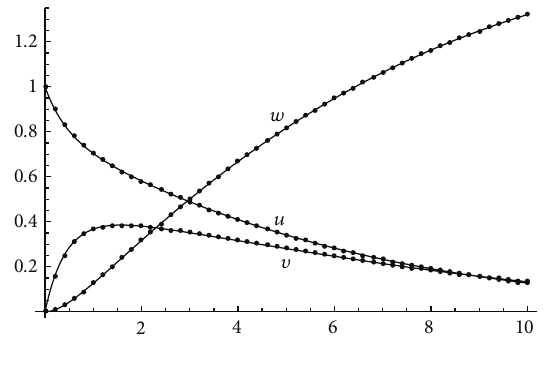
Figure 1: Profile of the normalized concentrations of the substrate 𝑢 , enzyme-substrate complex 𝑣 , and product 𝑤 for 𝑘 = 1 , 𝜆 = 0.5 , = 𝛼 = 𝛼 = 1 . MSDTM solution (solid line); Runge- 𝜀 = 0.6 , and 𝛼 1 2 3 Kutta method solution (dotted